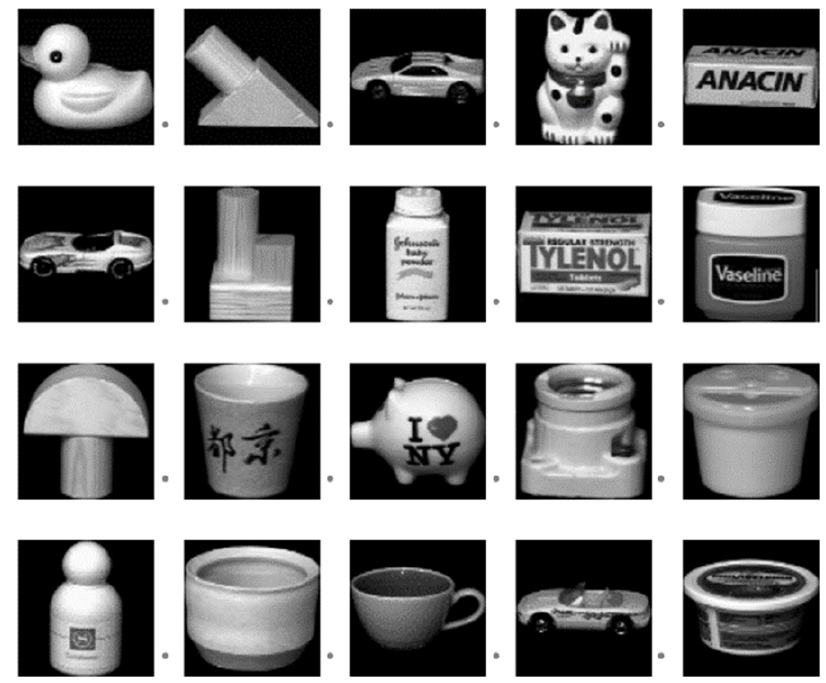
Figure 9. Examples of the COIL-20 database.